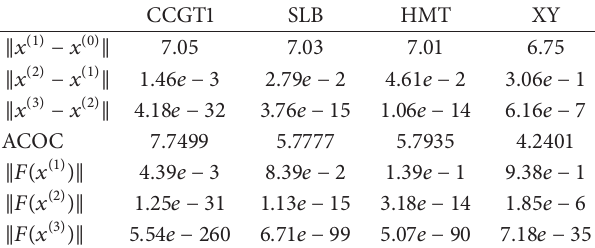
Table 7: Numerical results for Example 3 and initial guess 𝑥 (0) = (1,1,1,−1) 𝑇